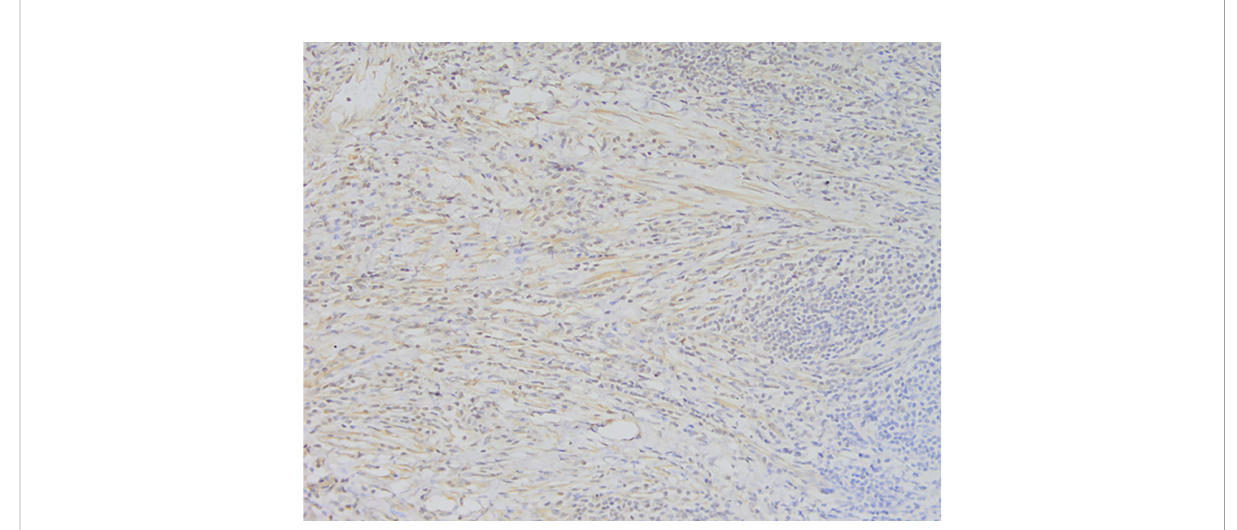
FIGURE 5 Representative image of vimentin expression(magni fi cation, ×200).